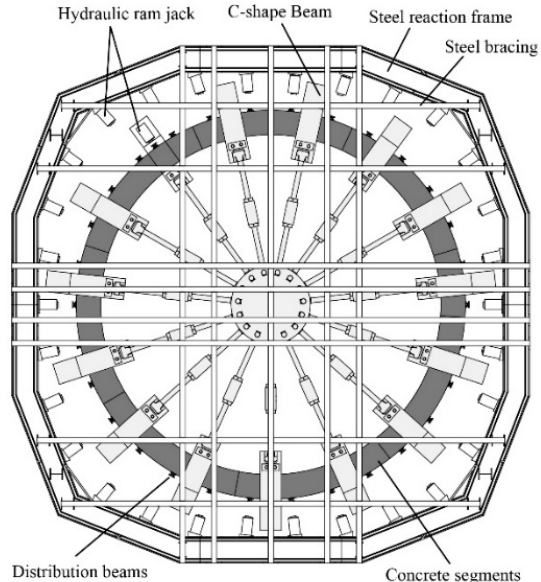
Figure 7. The setup of the loading test (top view).